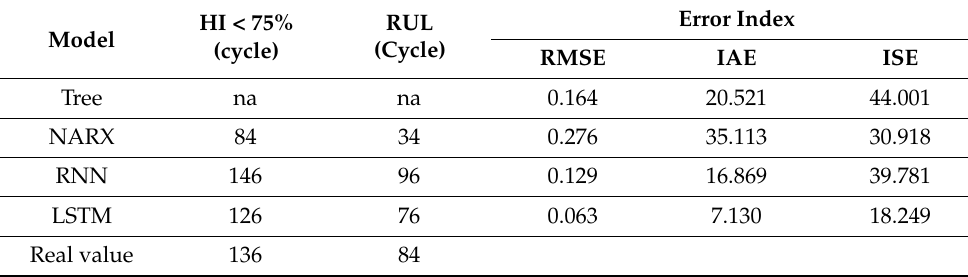
Figure 18. Prediction results of different training models. Table 8. Remaining useful life of different trained